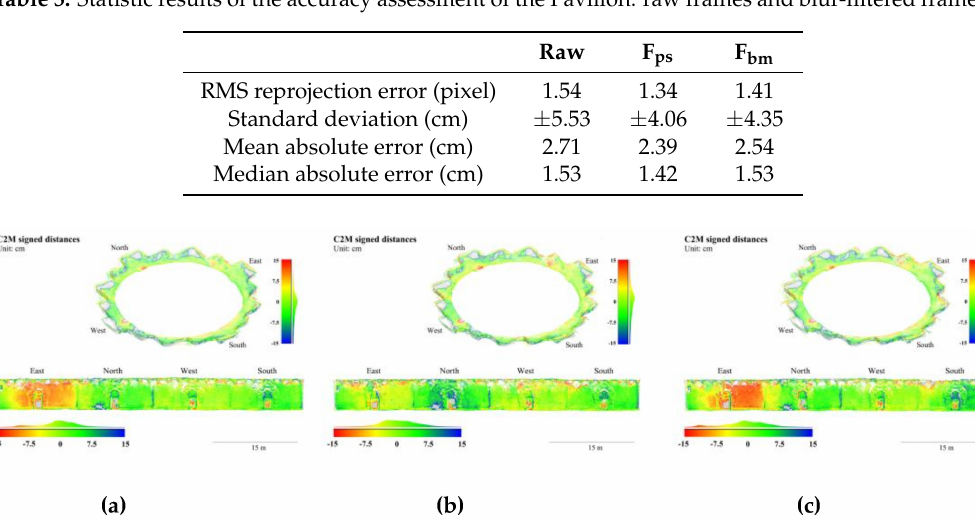
Figure 9. 3D points colored in signed distances to the GTM with variable blur filters of the Stupa. ( a ) Raw frames; ( b ) F ps ; and ( c ) F bm .